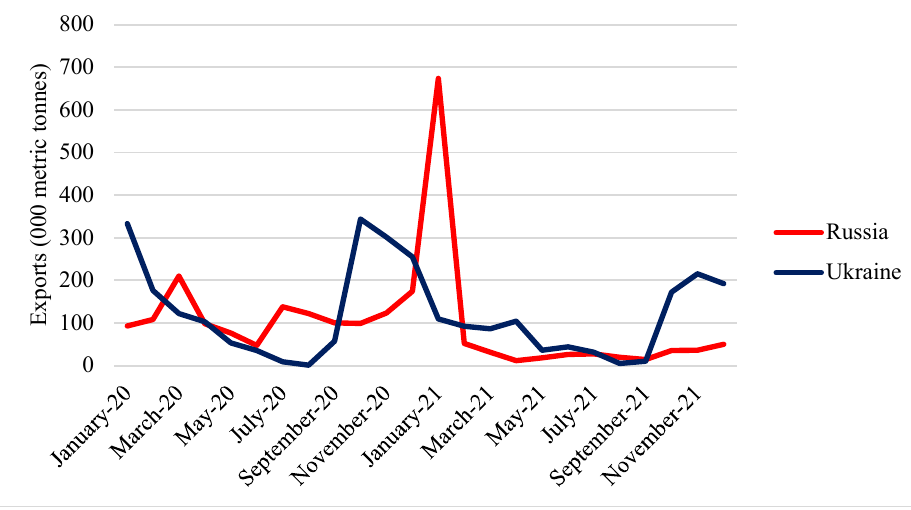
Figure 9. Export quantity of Russian and Ukrainian soybean in 2020 and 2021. Source: [30].